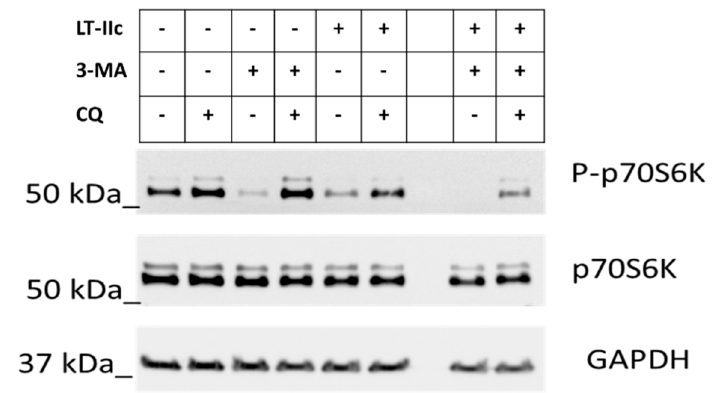
Figure 7. Effect of LT-IIc on p70S6K phosphorylation. MDA-MB-231 cells were treated with LT-IIc (5 µg/mL) ± 25 µM chloroquine (CQ) and/or 3-methyladinine (3-MA) (10 mM) as indicated. After 24 h treatment, cell lysates were harvested and analyzed by immunoblotting. Representative blot of three independent experiments.